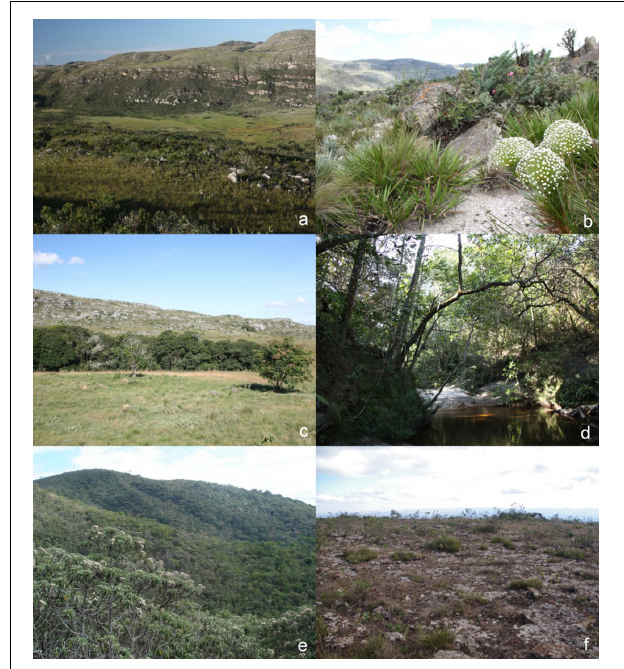
FIGURE 1 | Campos rupestres with different substrates in Minas Gerais. (a) Landscape of the Serra do Cipó, Mun. Santana de Pirapama, showing different open quartzite (OQ) vegetation types; (b) OQ - close-up of ‘cerrado-rupestre’ with Eriocaulaceae in the foreground at the Serra do Cipó; (c) forest on quartzite (FQ) - view of a forest grove in a matrix of open vegetation, Serra do Cipó; (d) FQ - Inside a riverine forest, Serra do Cipó; (e) FC - forest formation on canga at the Serra da Gandarela, Mun. Rio Acima; (f) open vegetation on canga (OC) - view of canga field at the Serra de Capanema, Mun. Catas Altas (photos a–d William Milliken; e–f Pedro L.